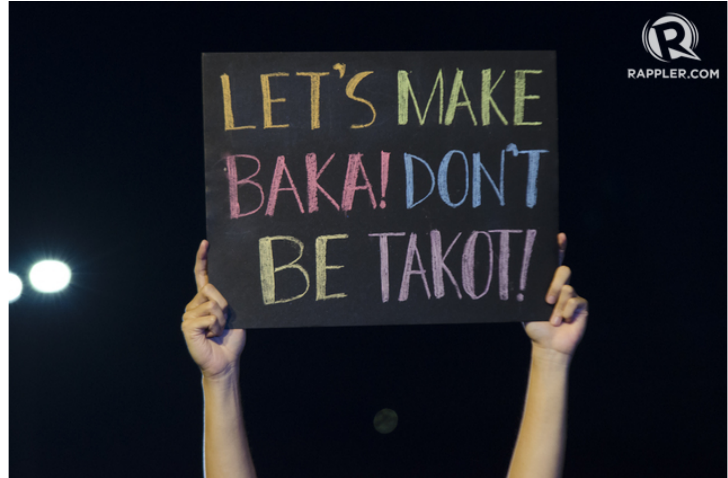
Figure 6. Bilingual protest sign. A playful way of encouraging the youth to ‘engage’ and to not be scared using a mock-activist tone, where ‘baka’ means ‘engage’, a word often used and associated with protests and mobilizations by the radical Left (Rappler